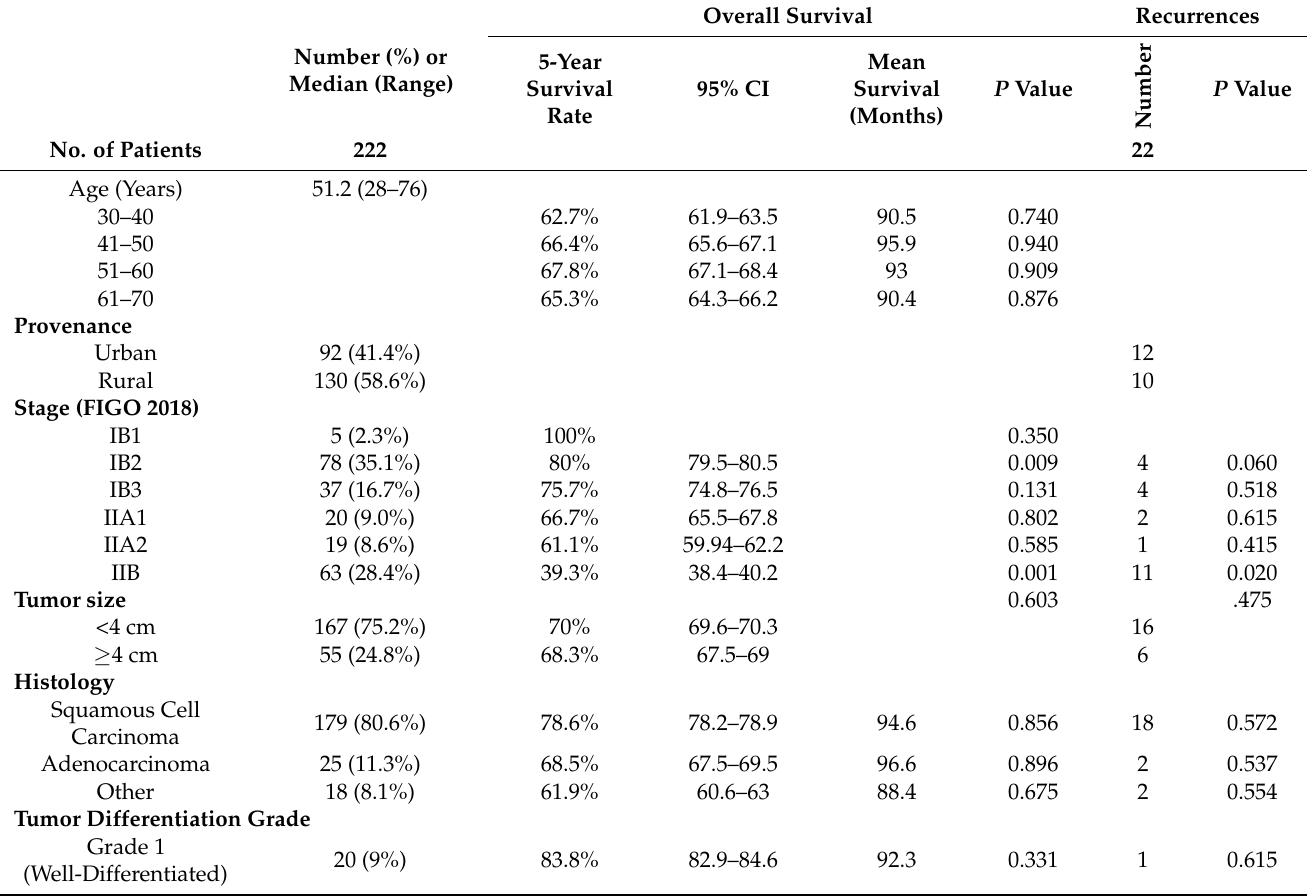
Table 1. Demographic and clinical characteristics of eligible participants; the univariate 5-year overall survival and the recurrence